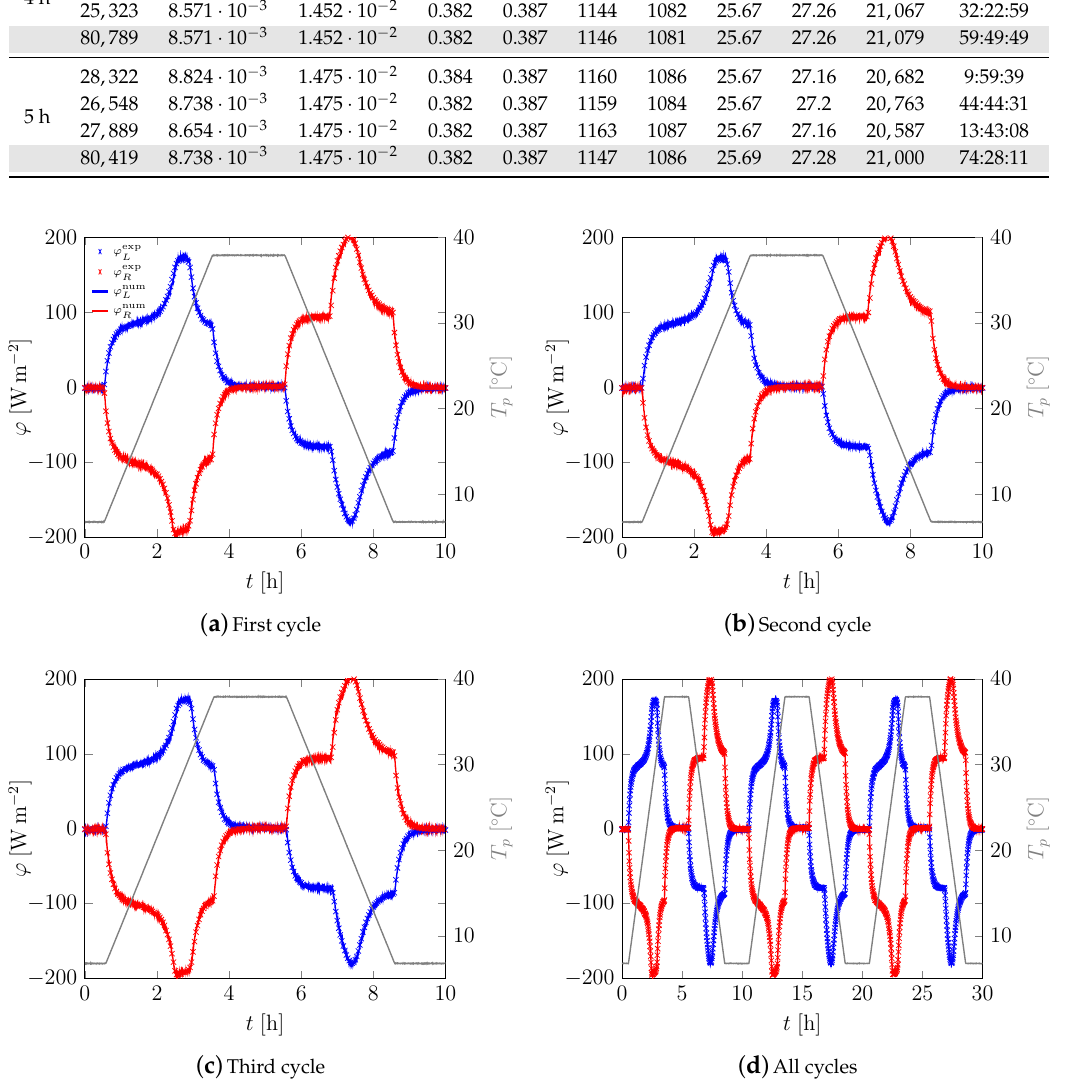
Figure A1. 12.4% w -PCM mortar: comparisons of the experimental fluxes with the numerical ones after identification for the 3h heating/cooling ramp